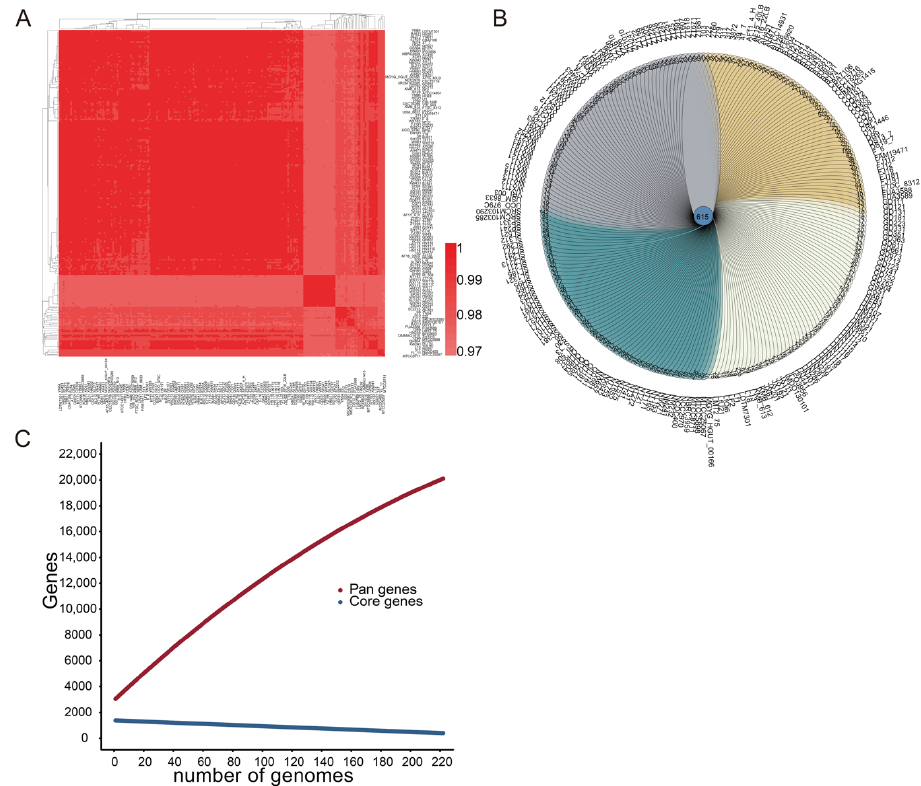
Figure 1. The genomic and genetic characteristics of 224 L. fermentum . ( A ) Average nucleotide identity scores of 224 L. fermentum . The color gradation from light red to dark red indicates an increase in genome similarity; ( B ) Venn diagram of the homologous clusters of 224 L. fermentum ; ( C ) Pan- and core-genome of 224 L. fermentum . The abscissa axis represents the number of genomes of L. fermentum and the vertical axis represents the number of pan- and core-genomes.